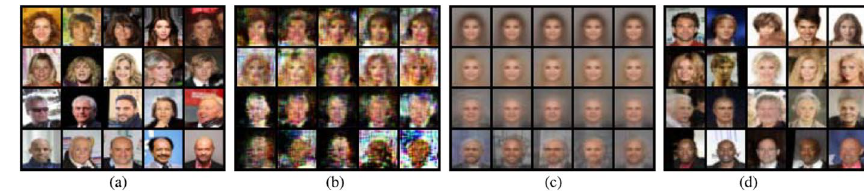
Fig. 23 Comparison of DeepSMOTE to other methods [499]. a Original images. b Balancing GAN [500]. c Generative adversarial minority oversampling [501]. d